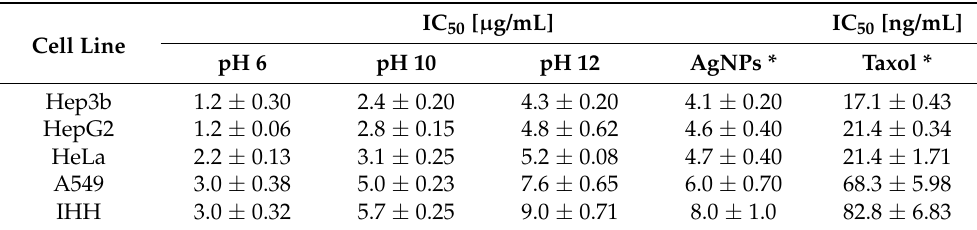
Table 3. Antiproliferative activity of AgNPs synthesized with cell suspension cultures extracts of Randia aculeata L. at different pH